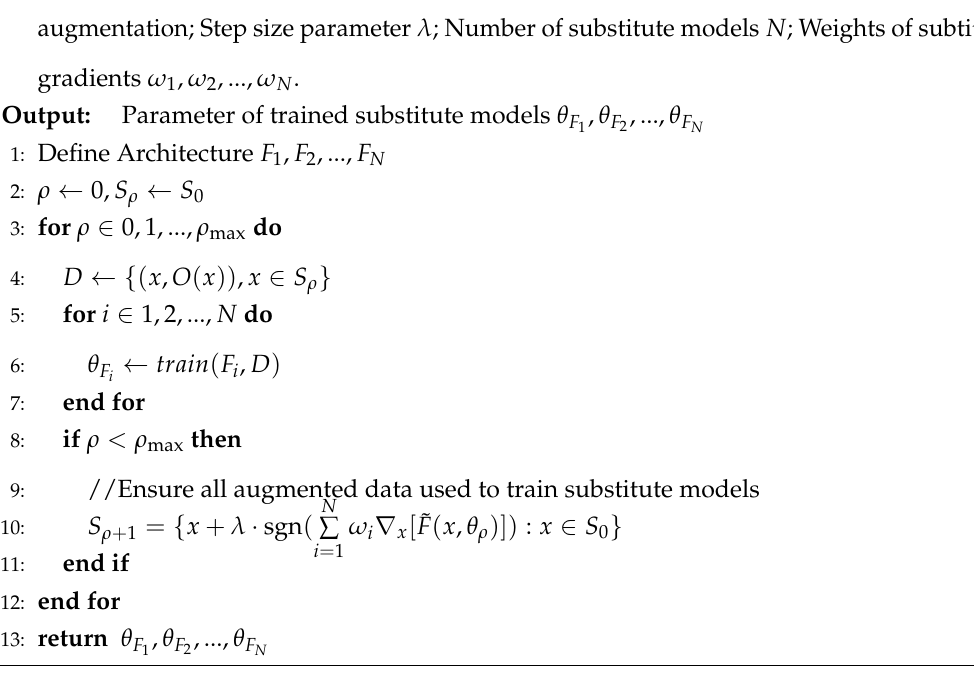
Algorithm 1 A gradient-based linear dataset augmentation method for ensemble